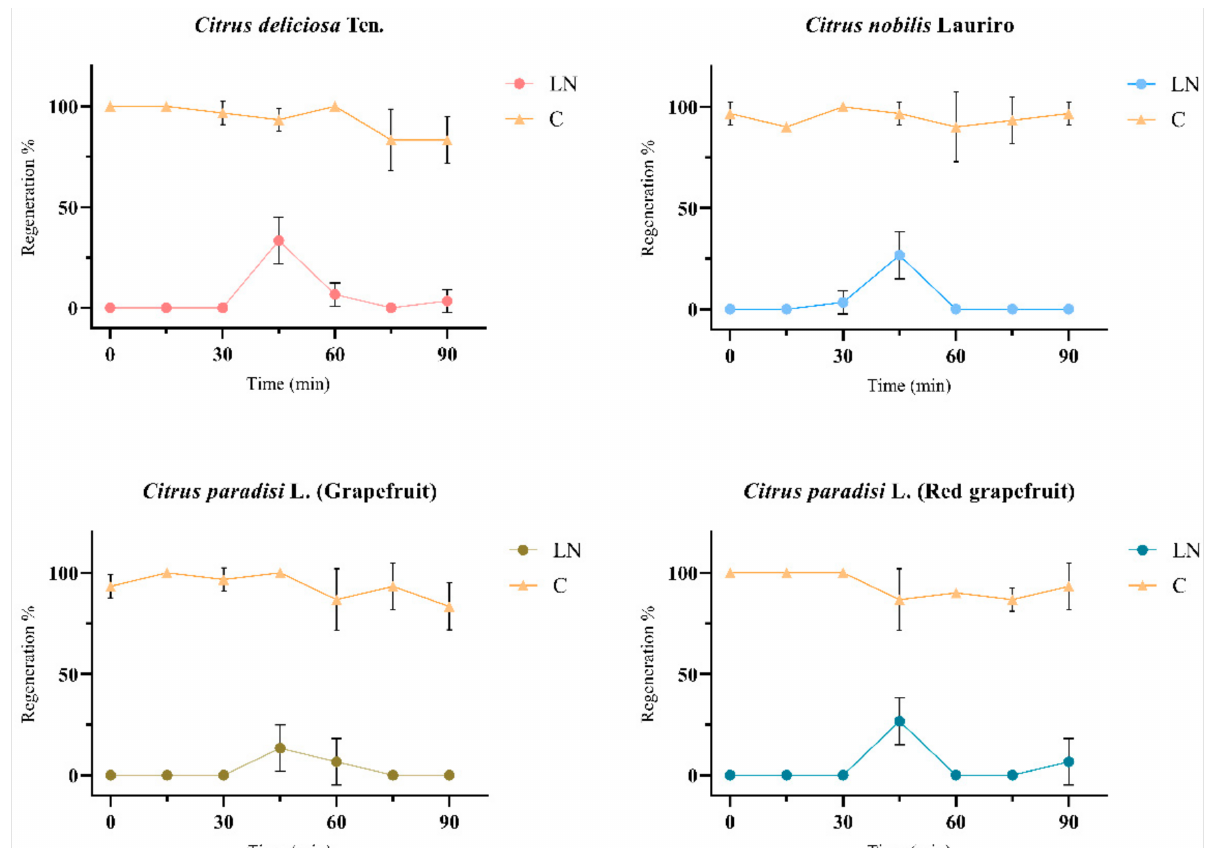
Figure 6. The shoot-tips regenerations of liquid nitrogen (LN) and control (C) groups of four different Citrus spp. cultivars after cryogenic applications on solid WPM medium supplemented with 1 mg.L − 1 BAP, 10 mg.L − 1 activated charcoal, and 1 mg.L − 1 H 3 BO 3 . The graphs were formed according